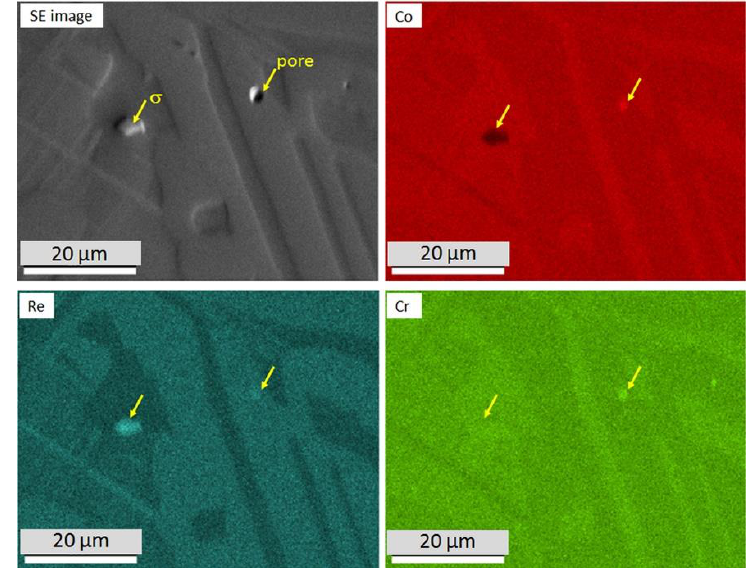
Figure 2. EDS maps from a combined EBSD + EDS measurement with highly tilted sample showing artefact: SE image and elemental maps of Co, Re and Cr. Table 2. Crystal structures of different phases present in Co-Re-Cr-Ni alloys and their lattice parameter values measured by neutron diffraction